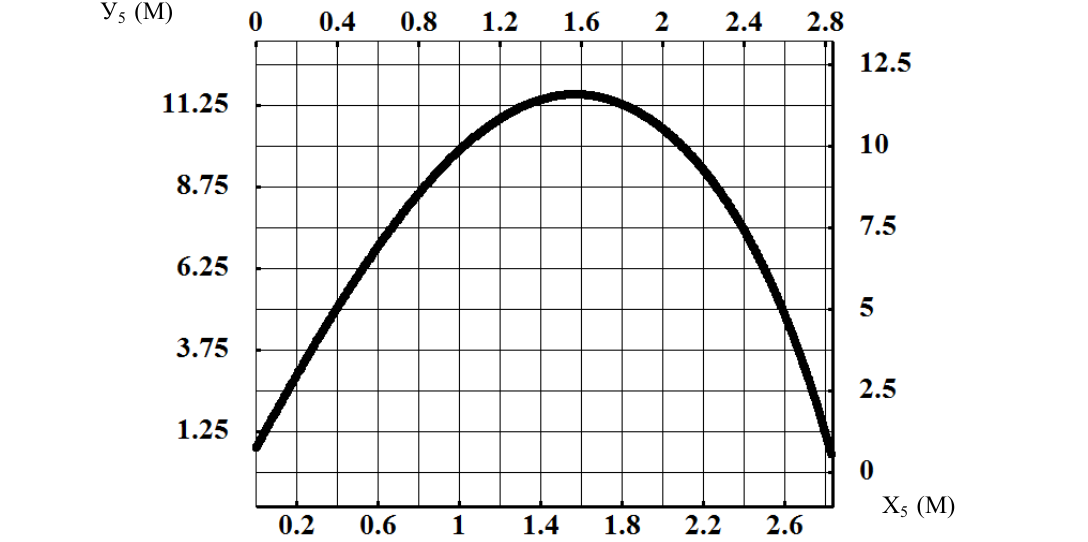
Fig.6. Graph dependence of parameters of clubs’ flight for time t=3sec.; VС 0 =21m/sec; α C0 =85 0 ; h Cо =0.75m.; 2m=